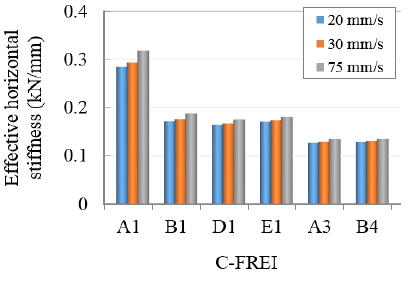
Figure 11. Effective horizontal stiffness of C-FREIs under different lateral cyclic rates (20, 30, and 75 mm/s) at 50% shear strain.